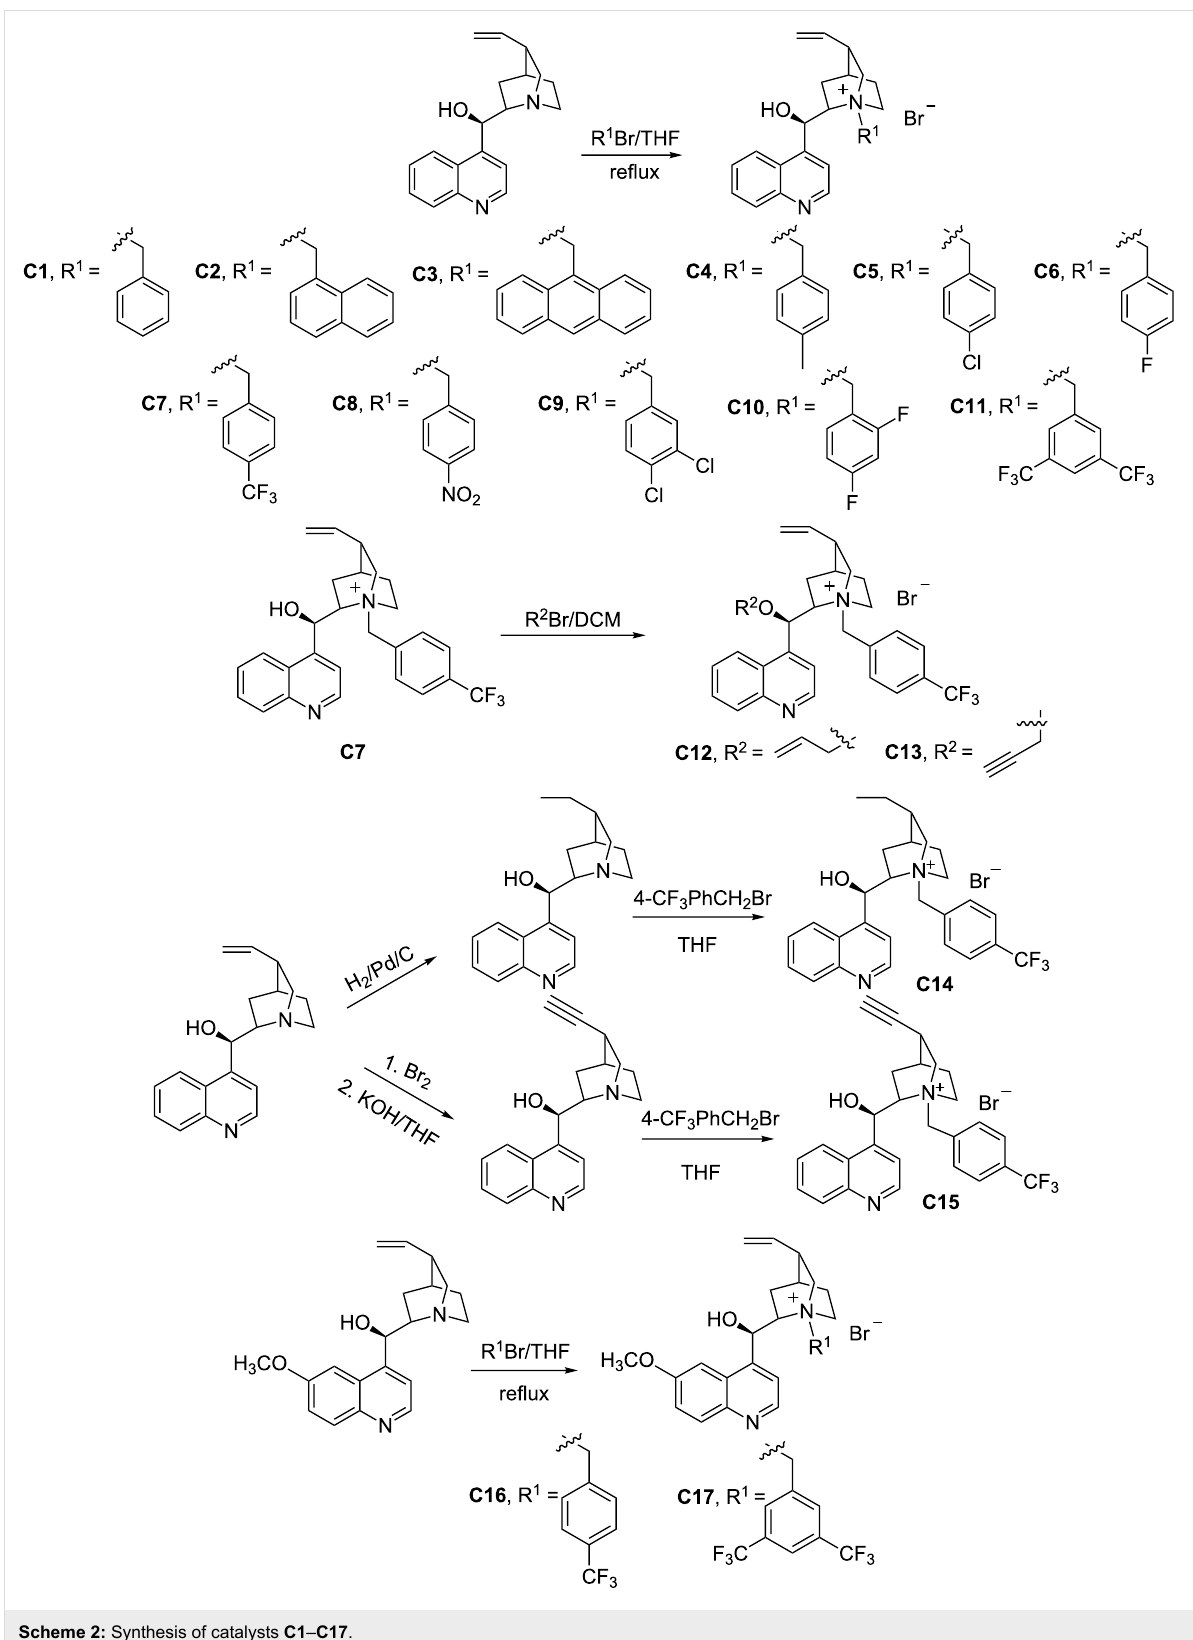
Scheme 2: Synthesis of catalysts C1 – C17